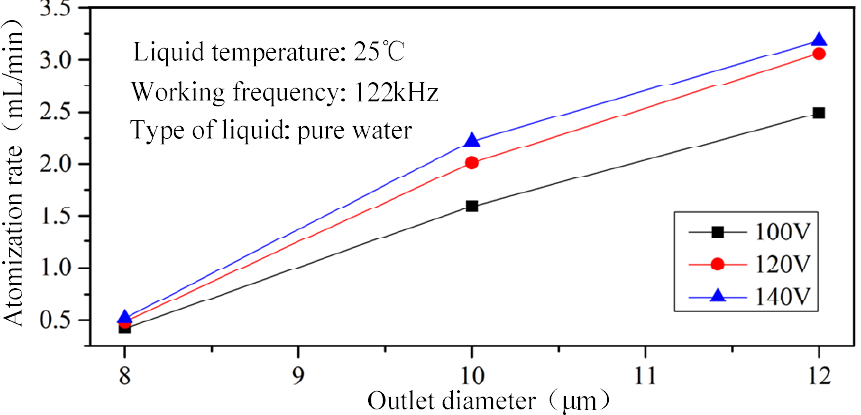
Figure 11. Outlet diameters of the micro-tapered apertures.